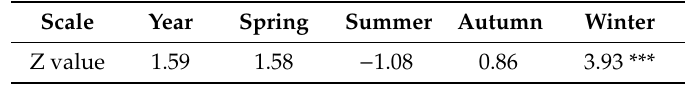
Table 1. Z-values from the Mann–Kendall (MK) test of reference evapotranspiration (ET 0 ) at di ff erent scales.